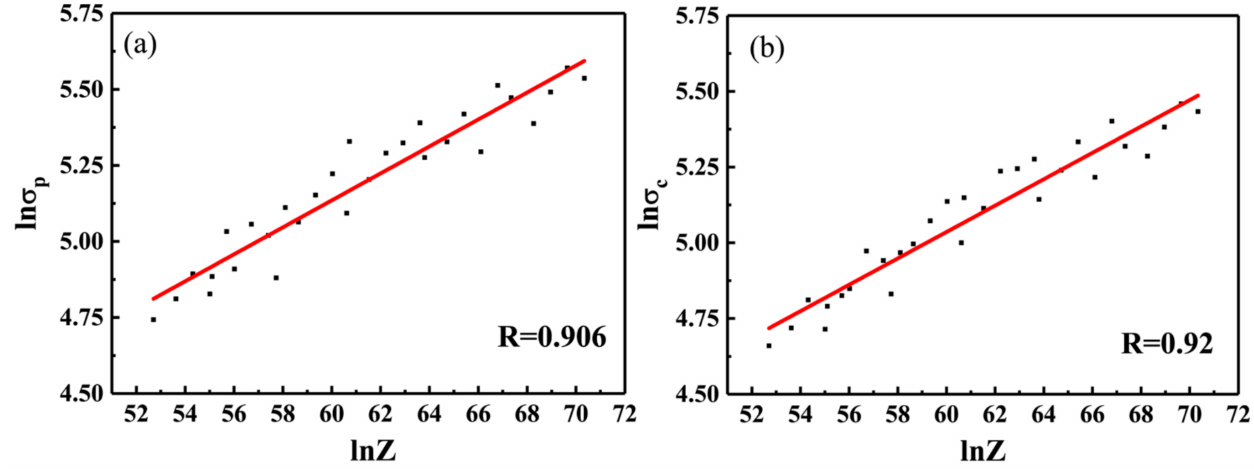
Figure 8. Plot of ( a ) 1n σ p -1n Z and ( b ) 1n σ c -1n Z